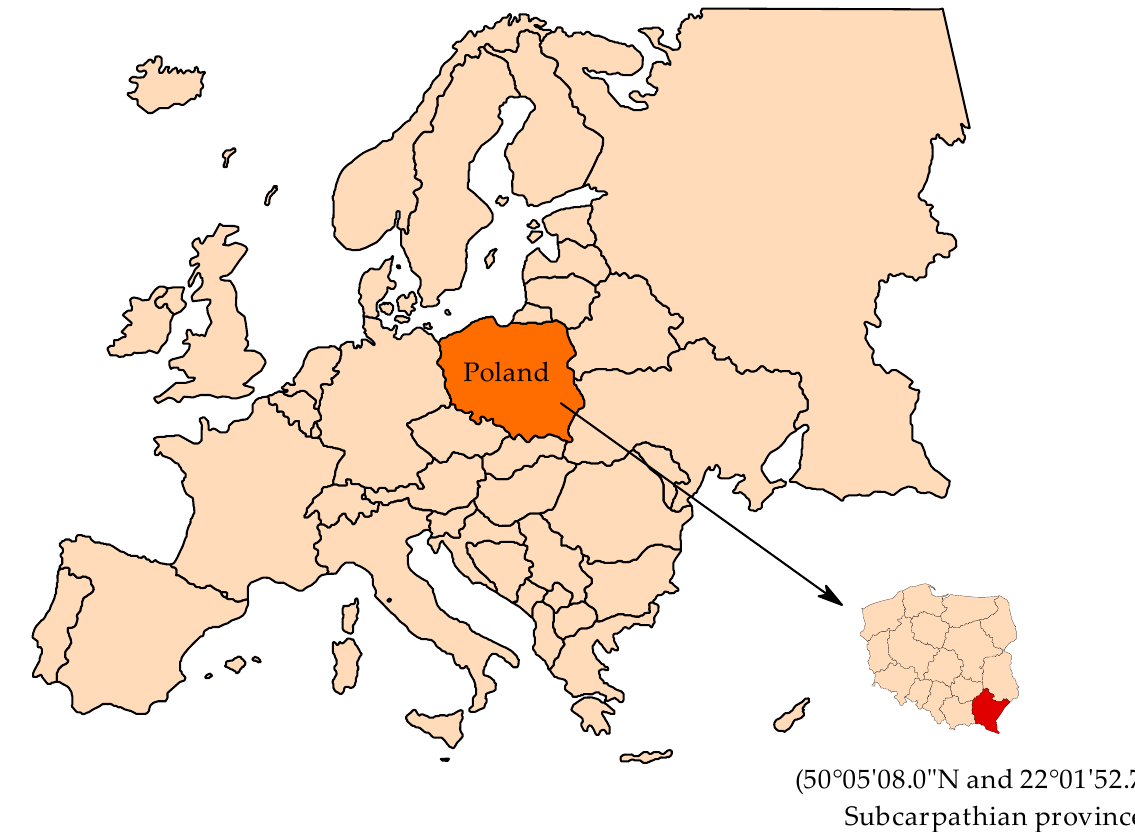
Figure 4. Location of the examined installation: Subcarpathian province, Poland (50°05 ′ 08.0 ″ N and 22°01 ′ 52.7 ″ E).